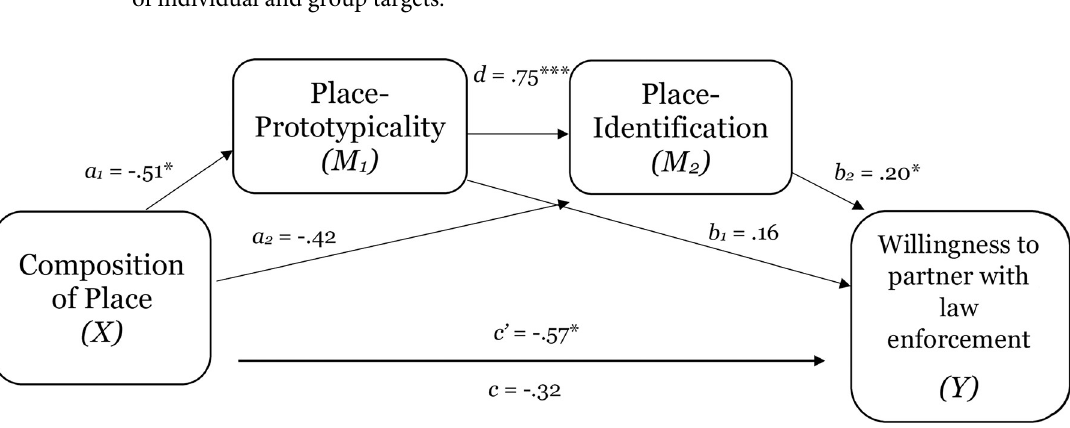
Fig 10. Test of the serial mediating effect of place-prototypicality and place-identification in the relation between composition of place and willingness to partner with law enforcement in study 2c. Notes: � p < .05, �� p < .01, ��� p < .001.